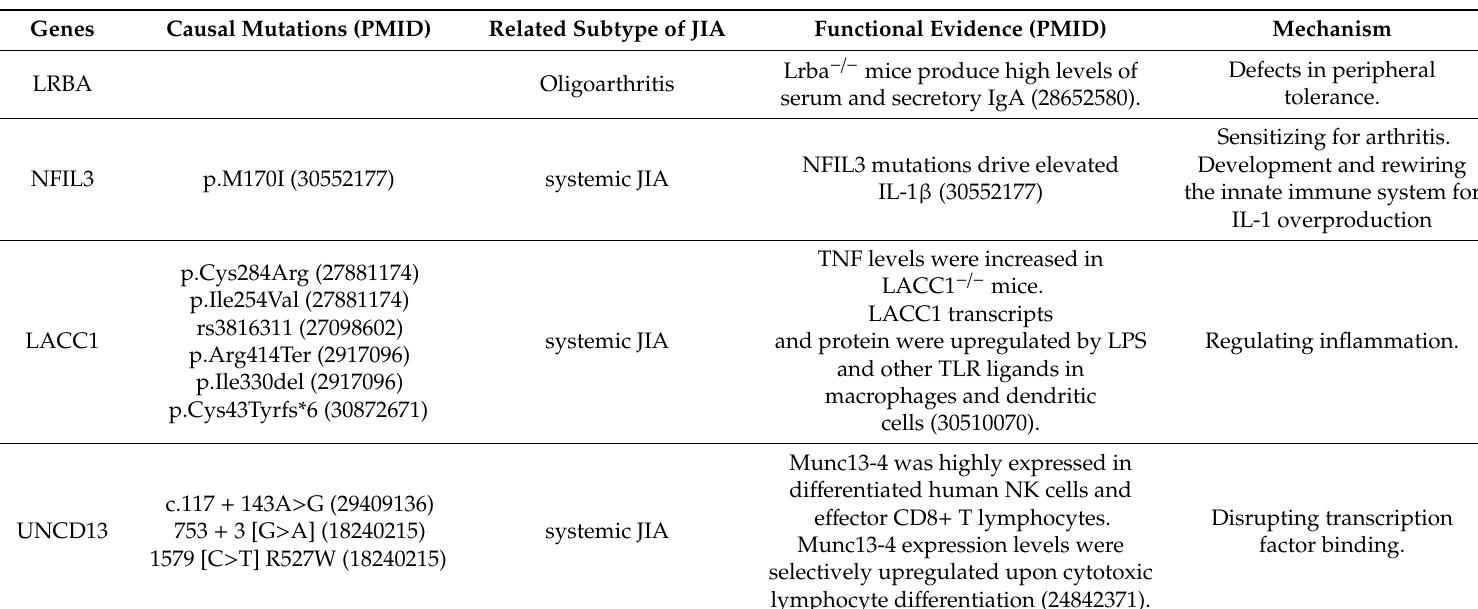
Table 1. The genes correlated with monogenic forms of juvenile idiopathic arthritis